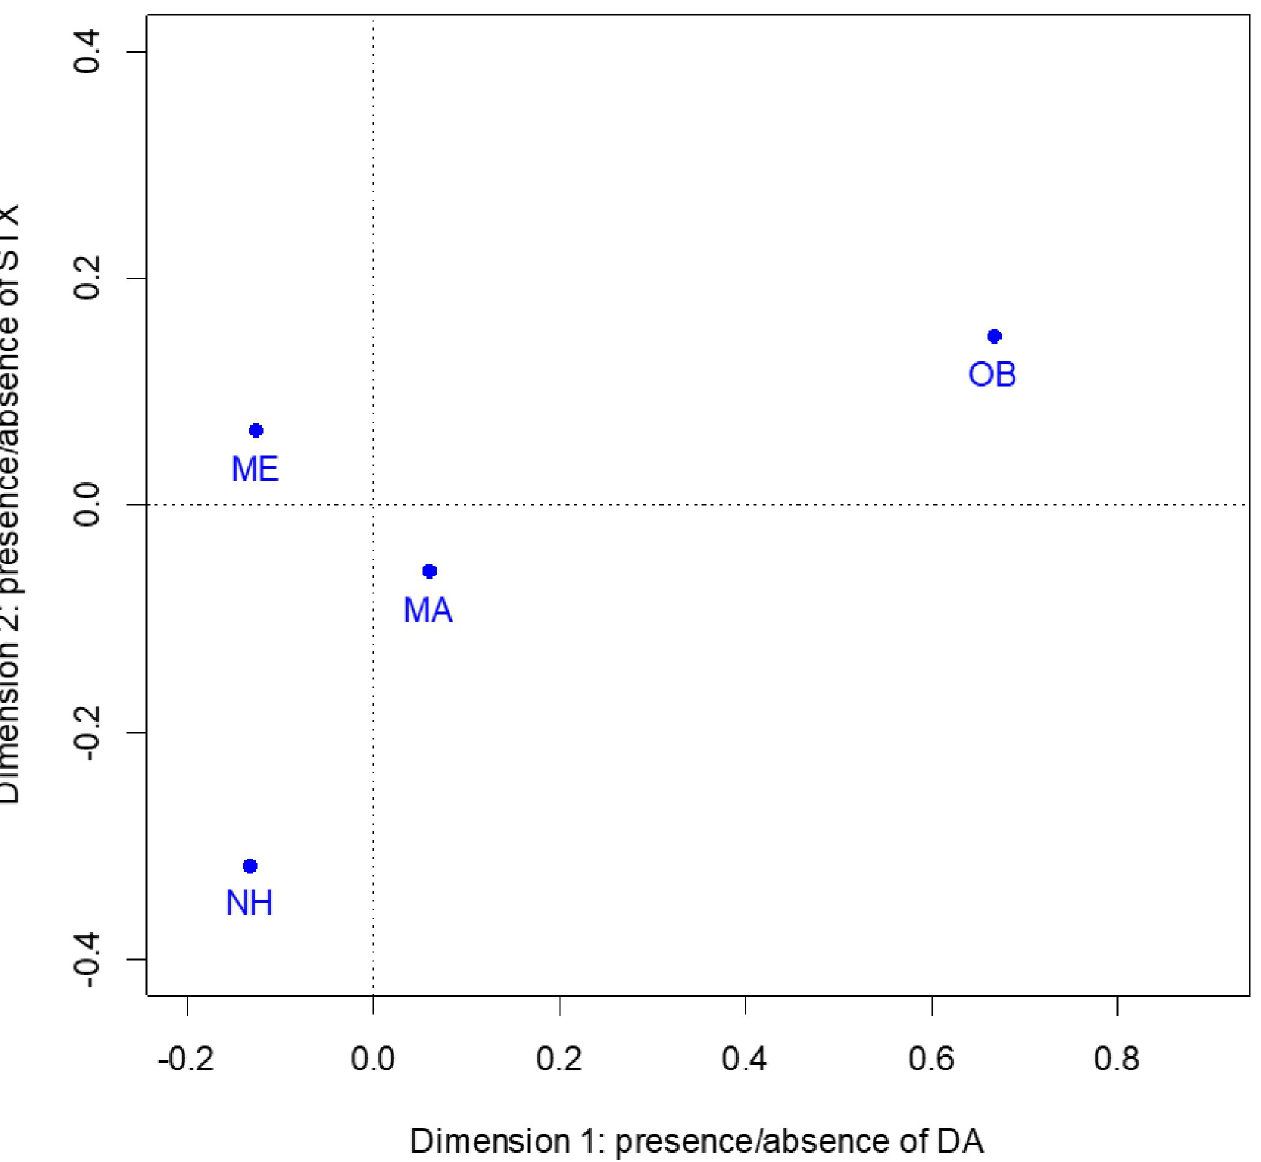
Fig 3. Correspondence analysis ordination for sub-region comparisons. Positive values for dimension 1 correlate with larger proportion of positive domoic acid samples and negative values correlate with larger proportion of negative domoic acid samples. Positive values for dimension 2 correlate with larger proportion of positive saxitoxin samples and negative values correlate with larger proportion of negative saxitoxin samples. MA = Massachusetts, ME = Maine, NH = New Hampshire, OB =